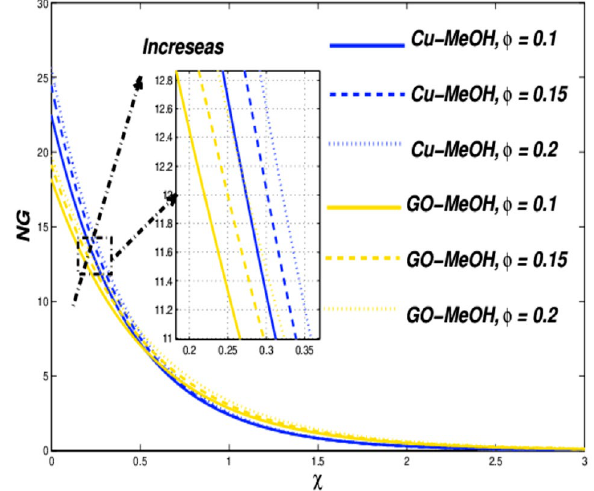
Figure 12. Entropy variation versus φ .